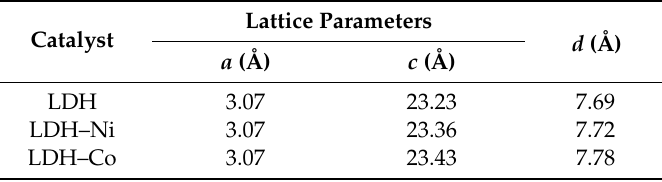
Table 1. Lattice parameters of synthesized hydrotalcites.